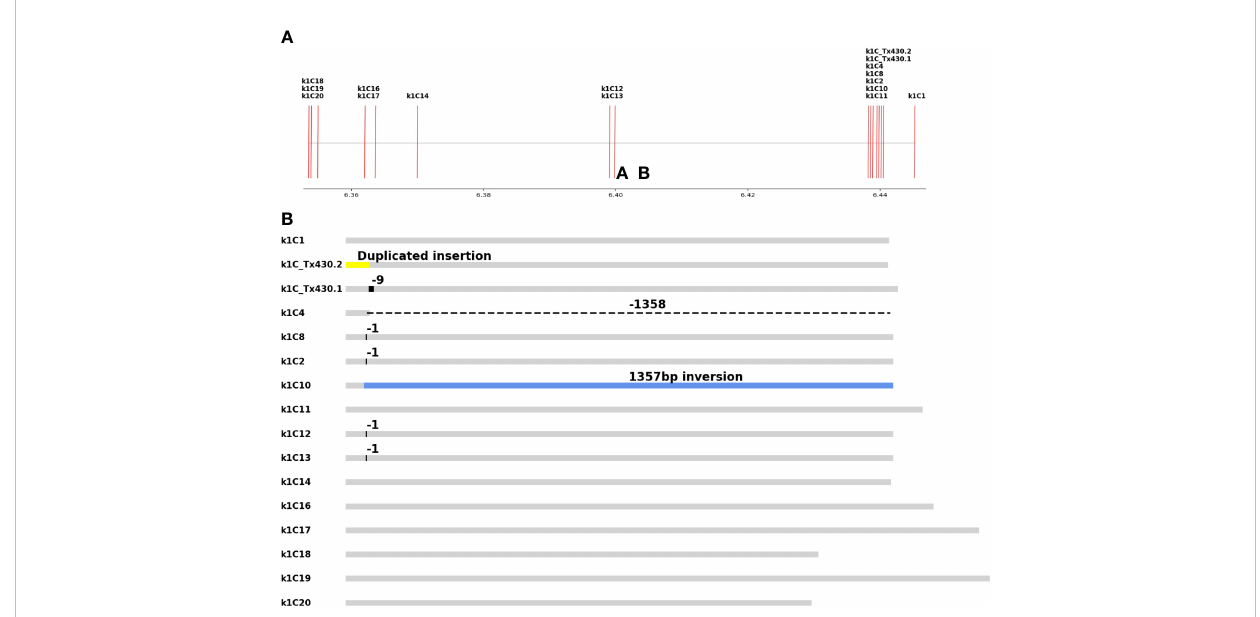
FIGURE 2 Edit characterization of 19Q4-13. (A) Genomic location of alpha ka fi rin gene copies on chromosome 5. X-axis values are chromosome 5 basepair 1x10e-7. (B) 8 out of 16 gene copies had an edited allele, ranging from 1bp deletions to large structural